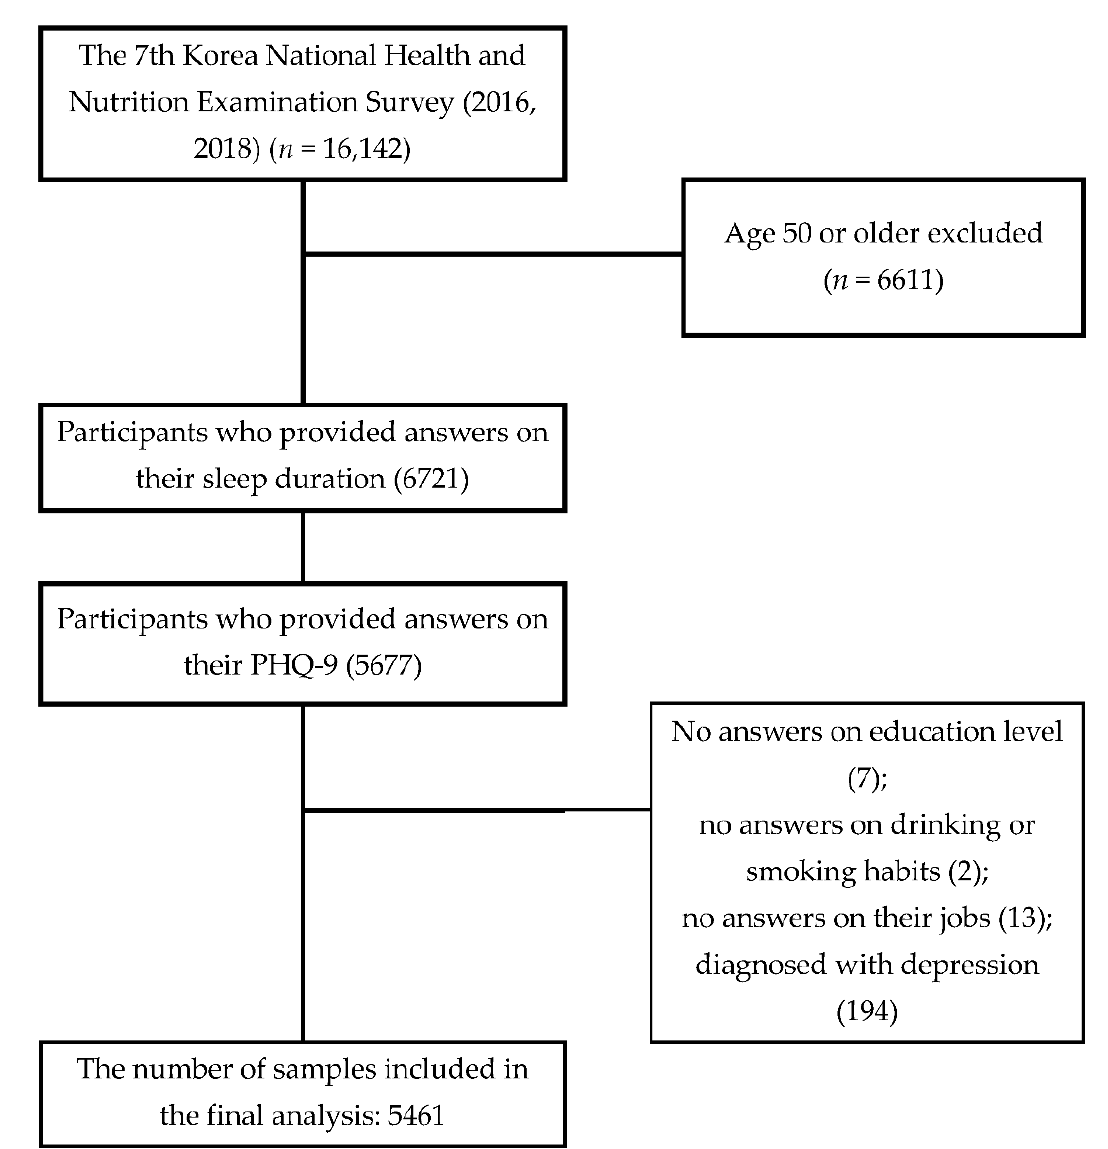
Figure 1. Flowchart of the sample selection. PHQ-9, Patient Health Questionnaire-9.